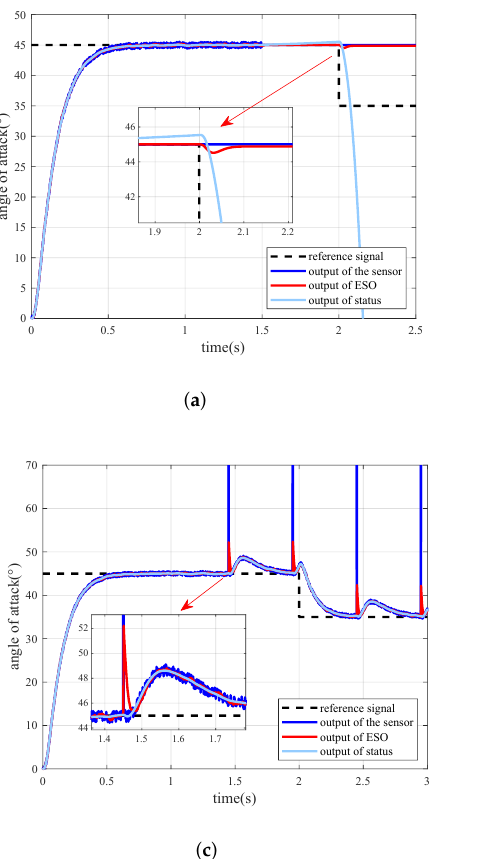
Figure 8. ( a ) Angle of attack under the stuck fault; ( b ) angle of attack under the gain variation fault; ( c ) angle of attack under the outlier data fault (the maximum outputs of the outlier data are 90 ◦ ). The results show that the designed PFTC cannot handle sensor faults, although it has better performance in actuator faults. The NSHV cannot follow flight instructions